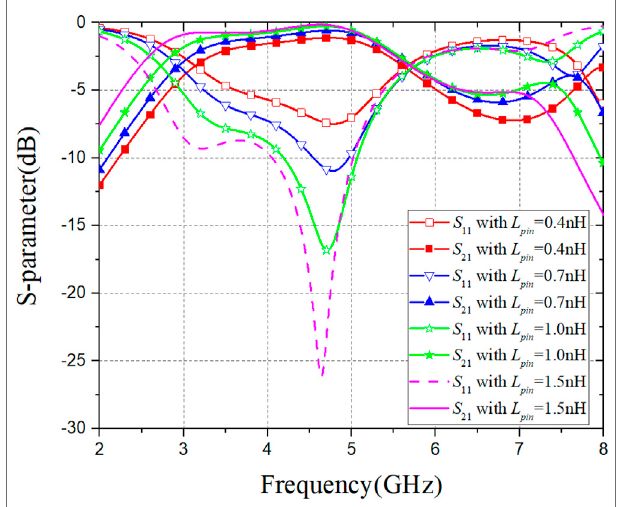
FIGURE 13 | Simulated results of lossless FSS with changing L pin when PIN diodes are turned